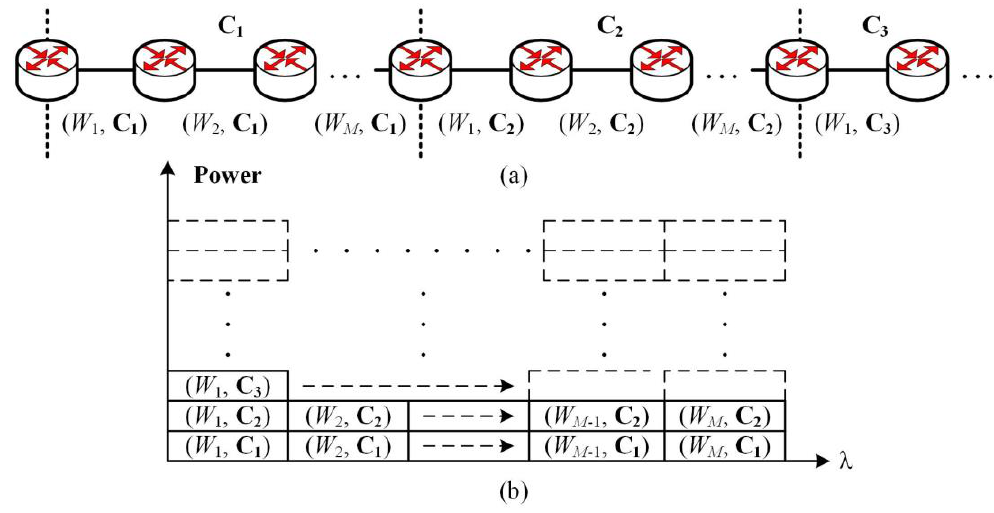
Figure 4. Sequential wavelength distribution: ( a ) label assignment to LSP, ( b ) PSD of the stacked labels.